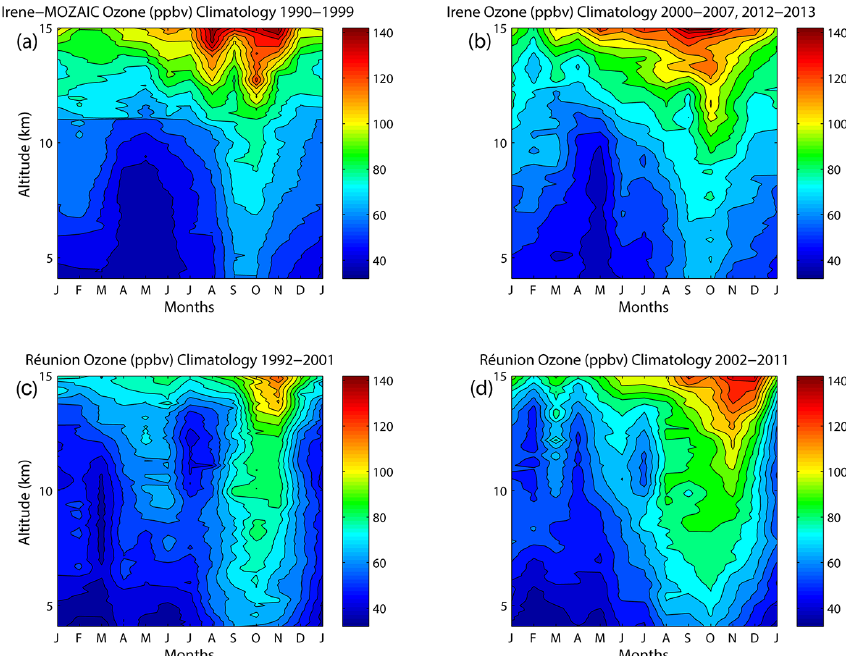
Figure 2. Seasonal cycle of free- and upper-tropospheric ozone over Irene, based on monthly averages for two periods of observations for Irene and Réunion: (a) Irene sondes from 4 to 15km (1990–1993, 1999) with MOZAIC ozone from 4 to 11km (1995–1999), (b) Irene (SHADOZ) sondes from 2000 to 2007 and 2012 to 2013, (c) Réunion (pre-SHADOZ and SHADOZ) sondes launched in 1992–2001, and (d) Réunion (SHADOZ) sondes from 2002 to